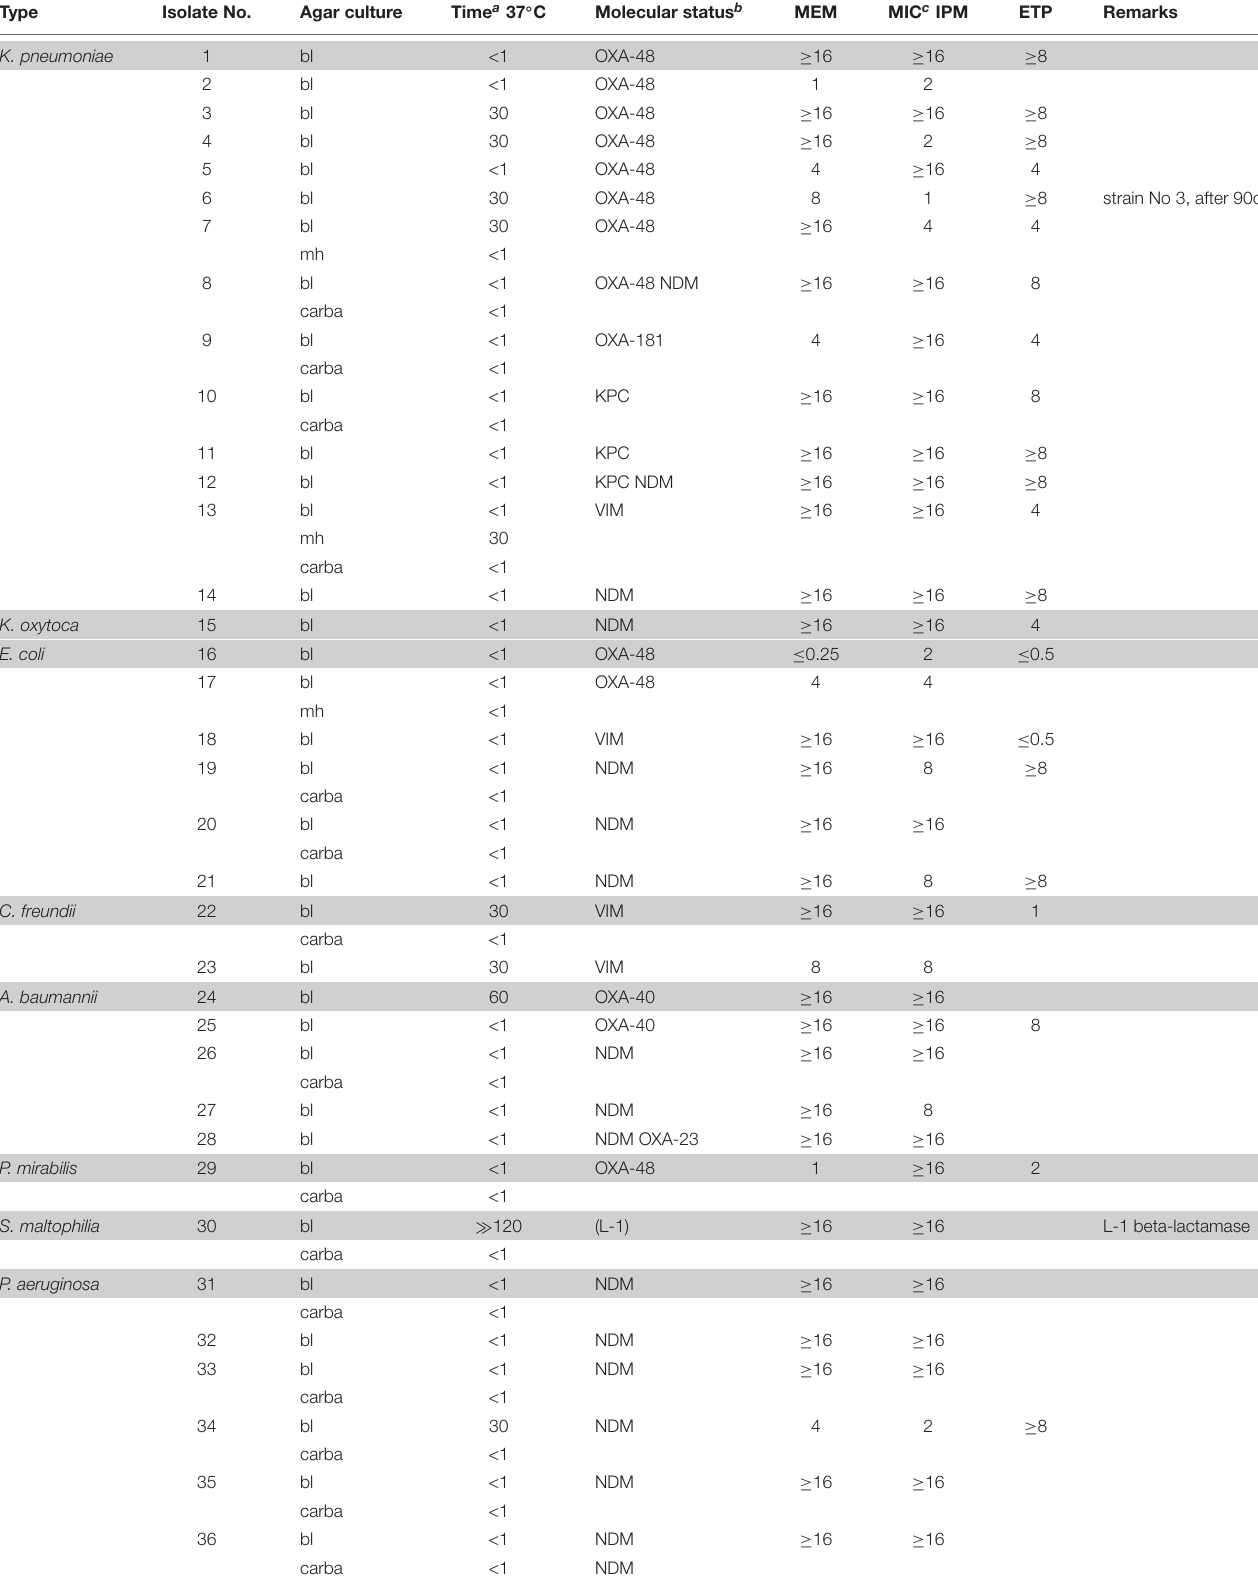
TABLE 1 | CarbaLux positive bacterial isolates. Type Isolate